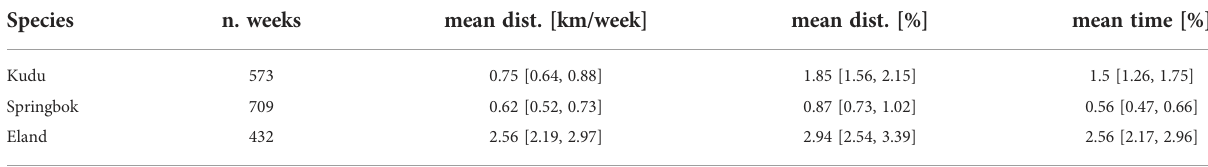
TABLE 2 Species-speci fi c averages of weekly distances (mean dist.) as absolute values [km/week] and percentage of total weekly distance [%] and averages of percentages of time (mean time) at fence lines. Species n.